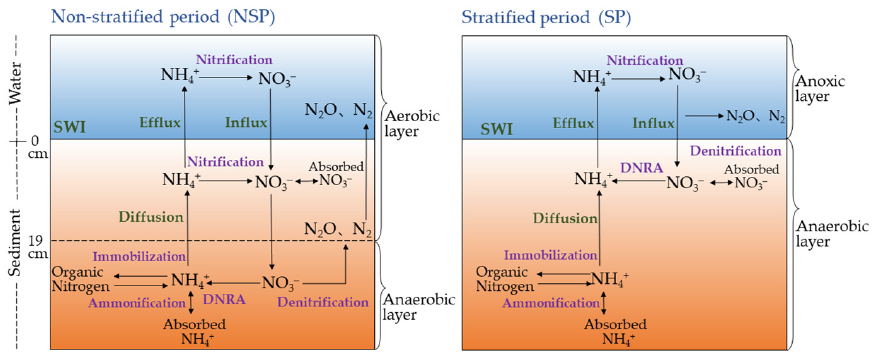
Figure 6. Schematic diagrams of major nitrogen biogeochemical processes at the SWI during the NSP and SP at the WJD reservoir.